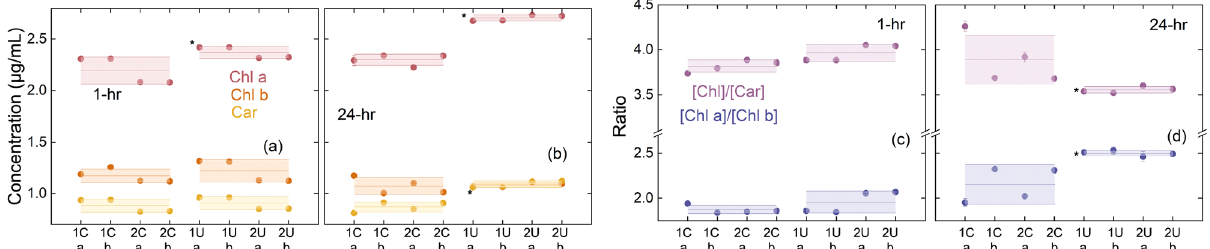
Figure 5. Pigment concentrations for each of the samples at ( a ) 1 h and ( b ) 24 h for the control and after exposure to U. The lines across each set of four data points are the mean for each exposure condition, and the shaded regions represent twice the standard error. The mean Chl a, Chl b, and Car concentrations ( µ g/mL), respectively, of the control samples for 1 h: 2.2, 1.2, and 0.9 & 24 h: 2.3, 1.1, 0.9. The mean Chl a, Chl b, and Car concentrations, respectively, of the U-exposed samples for 1 h: 2.4, 1.2, and 0.9 & 24 h: 2.7, 1.1, and 1.1. Relevant pigment ratios for each of the samples at ( c ) 1 h and ( d ) 24 h for the control and after exposure to U. The mean [Chl a]/[Chl b] and [Chl]/[Car] ratios of the control samples for 1 h: 1.8 and 3.7 & 24 h: 2.0 and 3.9. The mean [Chl a]/[Chl b] and [Chl]/[Car] ratios of the U-exposed samples for 1 h: 2.2 and 3.9 & 24 h: 2.5 and 3.6. In each, the mean and standard error are plotted over the 4 samples per exposure condition.The asterisks (*) next to the mean uranium data denote that the t-test found that they are statistically different from the mean of the control